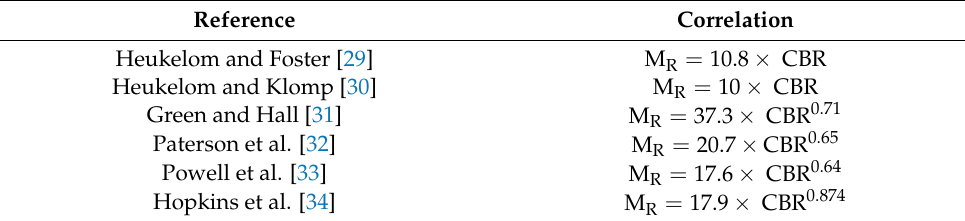
Table 4. Reviewed M R (MPa)–CBR (%) correlations.